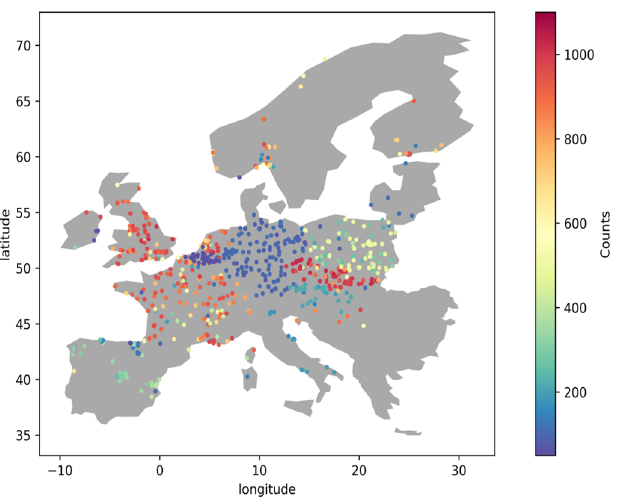
Figure 1. The location of PM 2.5 ground stations with the number of valid measurements used in this study.